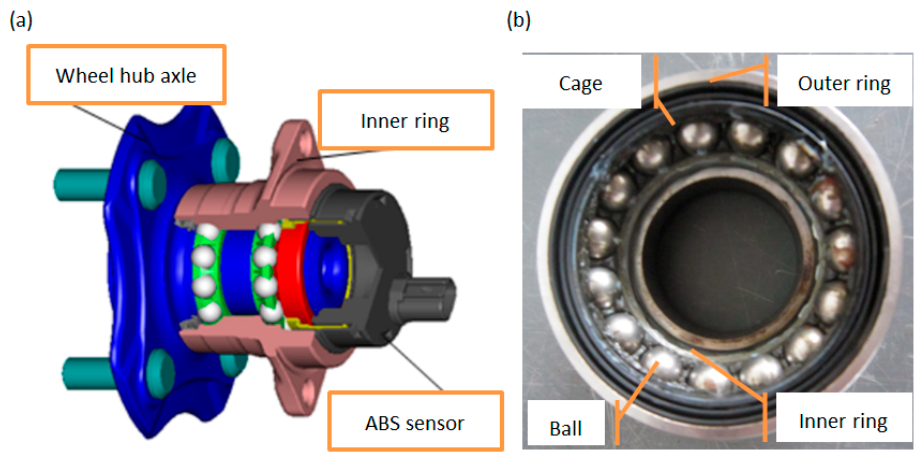
Figure 1. Wheel hub bearings: ( a ) wheel hub bearing unit; ( b ) wheel hub bearing structure.